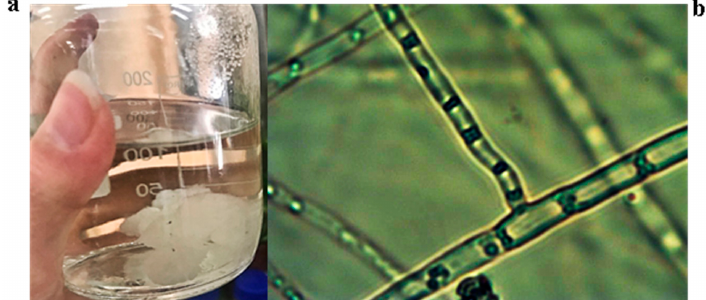
Figure 1. Macromorphological ( a ) and micromorphological ( b ) characteristics of the cotton-like mycelium (100×). Processes 2020 , 8 , x FOR PEER REVIEW